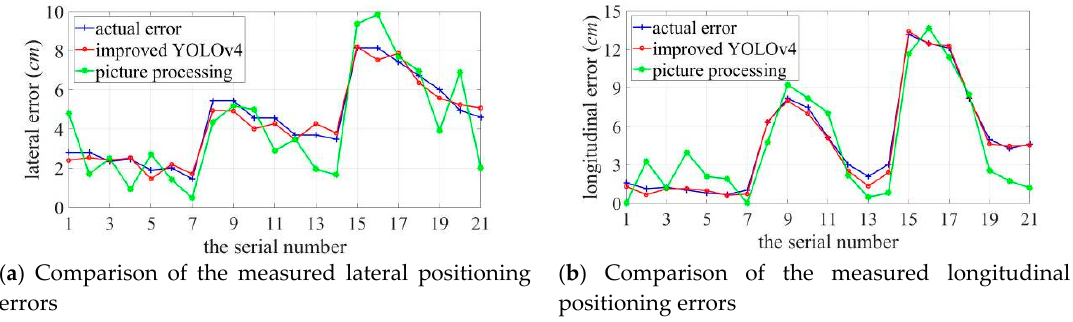
Figure 17. Comparison of the measured positioning errors.